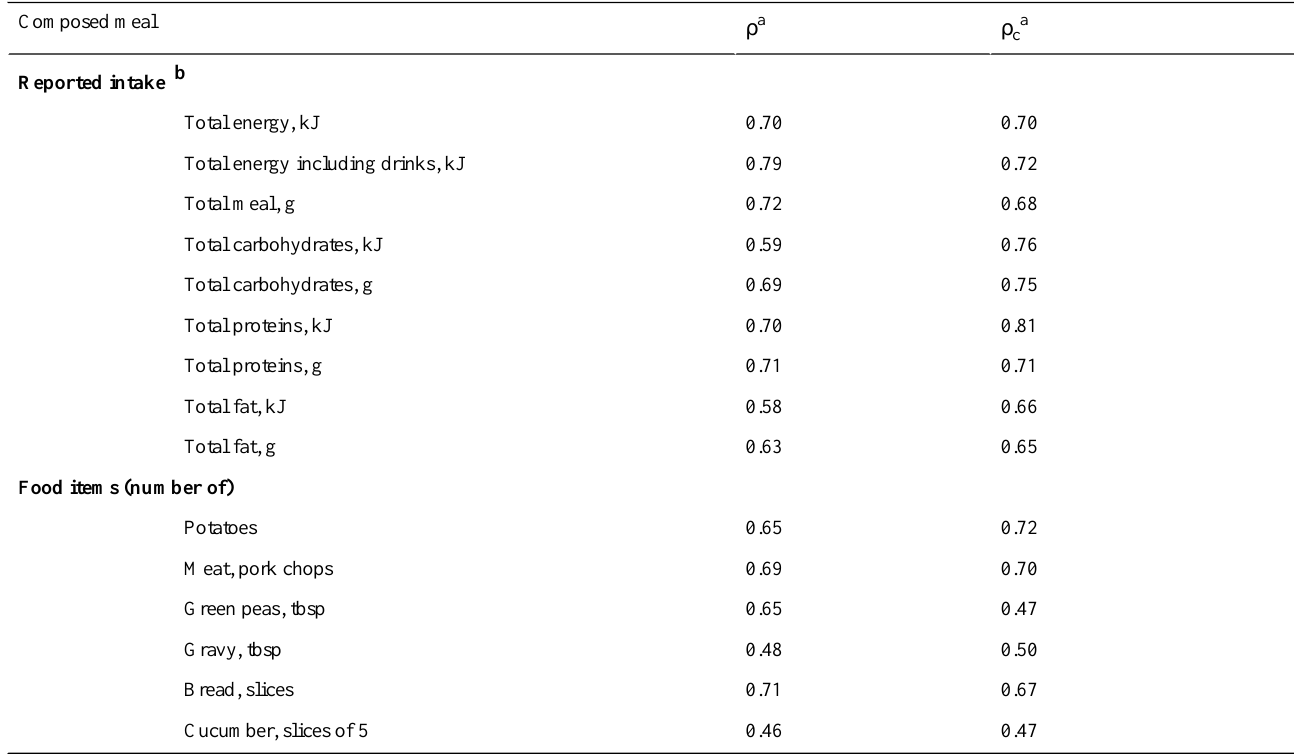
Table 4. Spearman rank correlations ( ρ ) and concordance correlation coefficients ( ρ c ) between the participants’ composed meals using the two meal instruments